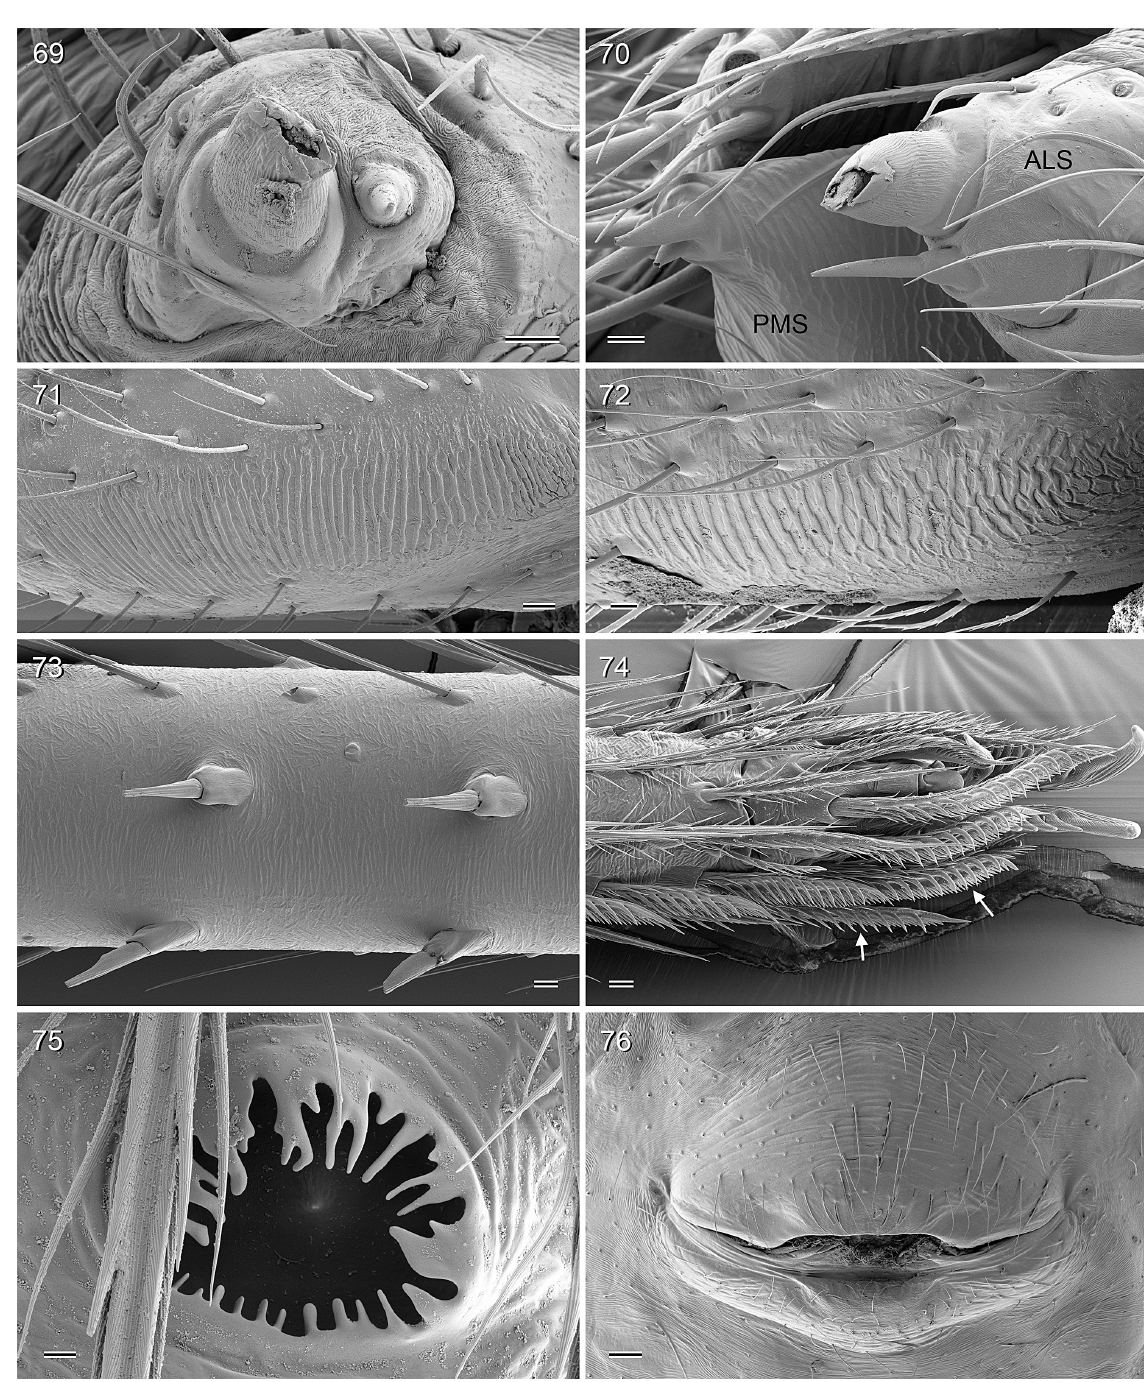
Figs 69–76. Stygopholcus skotophilus Kratochvíl, 1940; male and female from Ilijina pećina, Bosnia and Herzegovina (ZFMK (Ar 22198)). 69 . Male ALS. 70 . Female ALS and PMS. 71–72 . Stridulatory files on male and female chelicerae. 73 . Spines on male femur 1. 74 . Tip of male right tarsus 4, ventral view; arrows point at comb-hairs. 75 . Tarsal organ on male tarsus 4. 76 . Epigynum, ventral view. Abbreviations: ALS = anterior lateral spinneret; PMS = posterior median spinneret. Scale bars: 69–70, 72, 74 = 10 µm; 71, 73 = 20 µm; 75 = 2 µm; 76 = 100